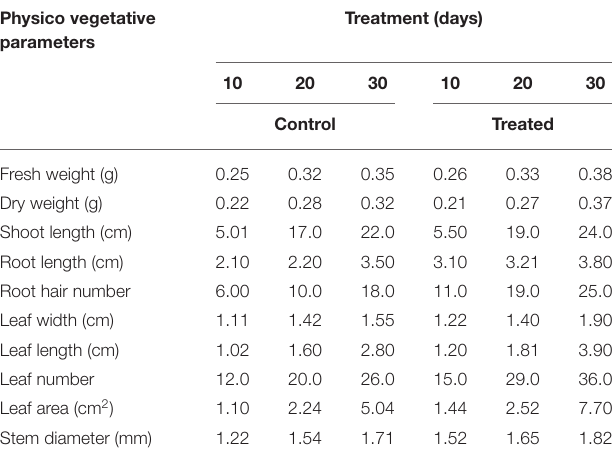
TABLE 5 | Effect of Bacillus sp. PG-8 on the growth of Arachis hypogea